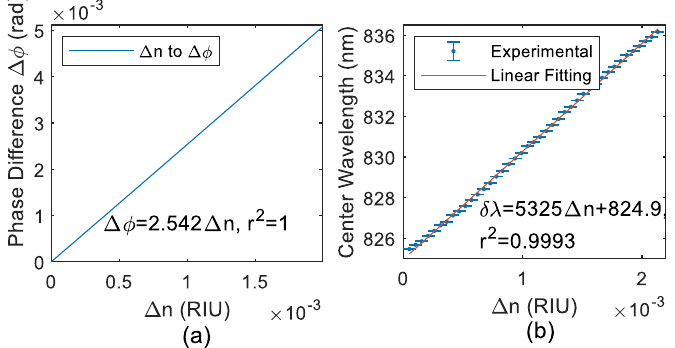
Figure 5. ( a ) In the system of this paper, the relationship between the refractive index change of the sample and the phase change of the system. ( b ) Relationship between the center wavelength shift of the system and the refractive index of the sample.